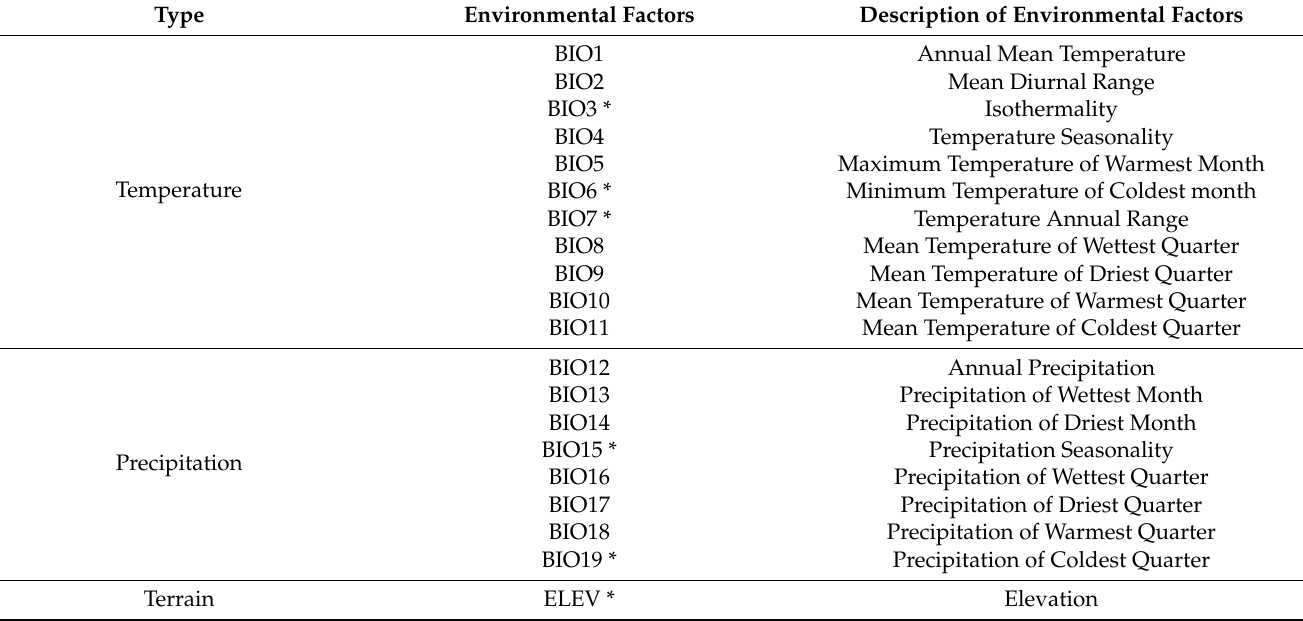
Table 1. The 24 environmental factors used in this